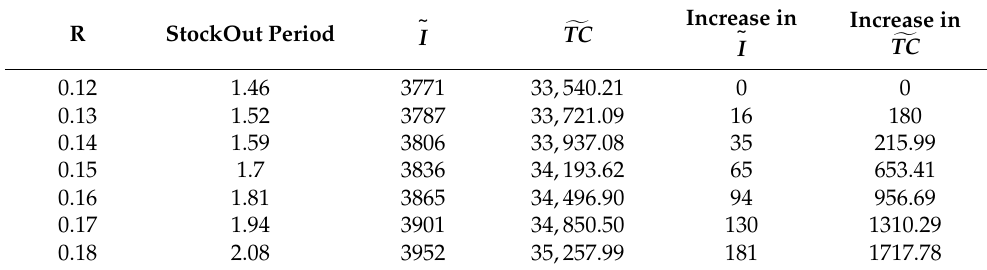
Table 1. Effect of inflation rate on optimizing the total